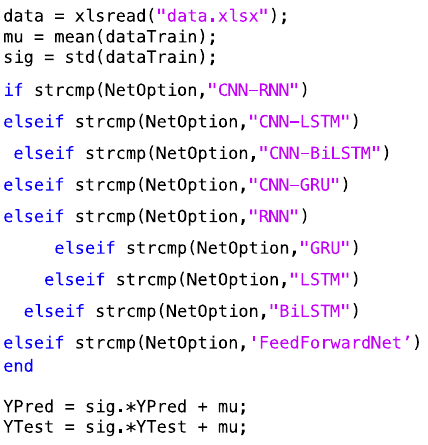
Figure 10. Pseudocode of the proposed hybrid DL algorithms.